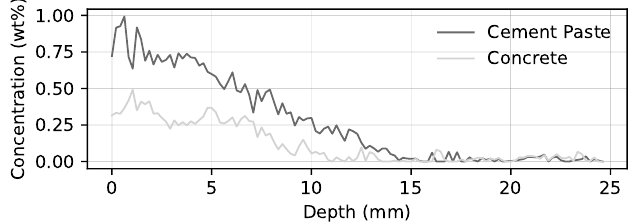
Figure 12. Comparison of depth dependent chloride content (chloride profile) of an in situ specimen with and without consideration of